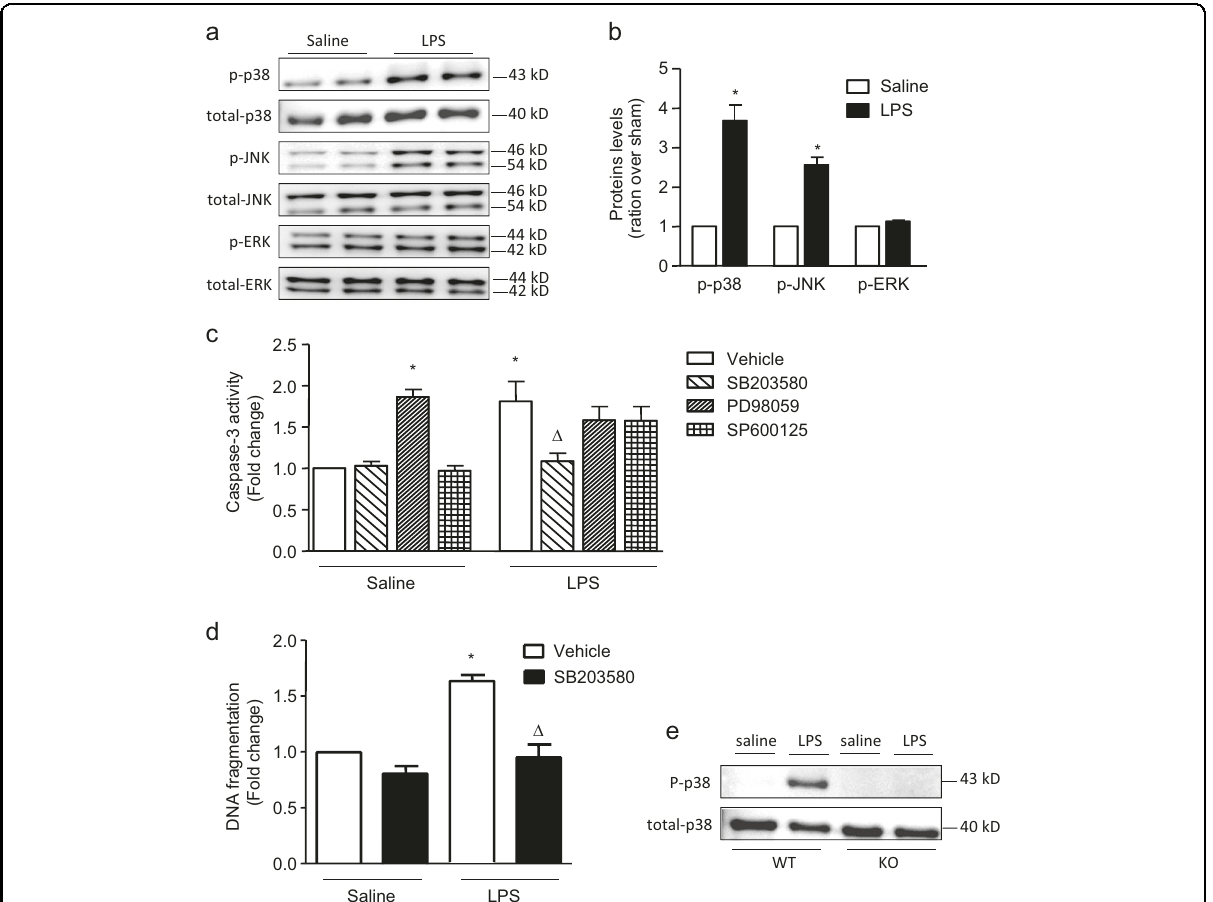
Fig. 3 Role of MAPK family members in the apoptosis of LPS-stimulated PMECs. PMECs were stimulated with LPS (1 µg/ml) for 18 h. a Expression levels of total and phosphorylated p38, JNK (46 and 54 kDa, respectively) and ERK1/2 (42 and 44 kDa, respectively) were determined by western blot analysis. b The corresponding bands were quanti fi ed via densitometry (phospho/total protein, presented as fold changes with respect to Sham). In addition, PMECs were treated separately with MAPK inhibitors (10 µmol/l SB203580, 10 µmol/l PD98059 and 20 µmol/l SP600125) for 1 h and were then stimulated with LPS (1 µg/ml) for an additional 18 h. Caspase-3 activity ( c ) and DNA fragmentation ( d ) were assessed. e Changes in p38 phosphorylation in LPS-treated mice with endothelial-speci fi c Capn4 knockout (KO) were determined by western blot analysis, and a representative image is shown. The data are presented as the means ± SD of 3 independent experiments. * P < 0.05 vs. the Sham vehicle group. Δ P < 0.05 vs. the LPS vehicle